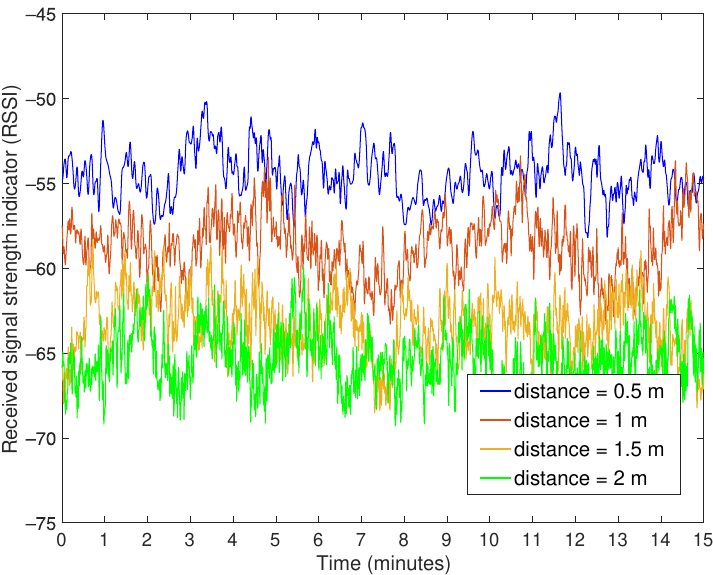
Figure 5. Bluetooth measurements in a static indoor scenario at various